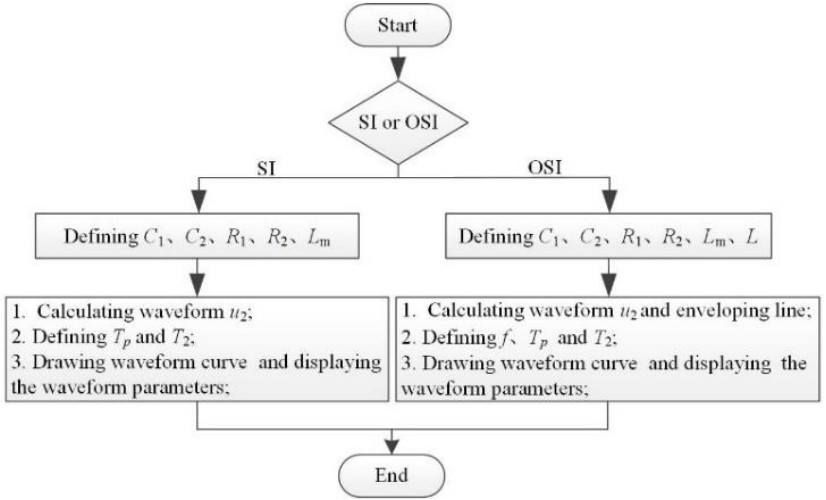
Figure 6. Subprogram flowchart of the waveform-parameter calculation.